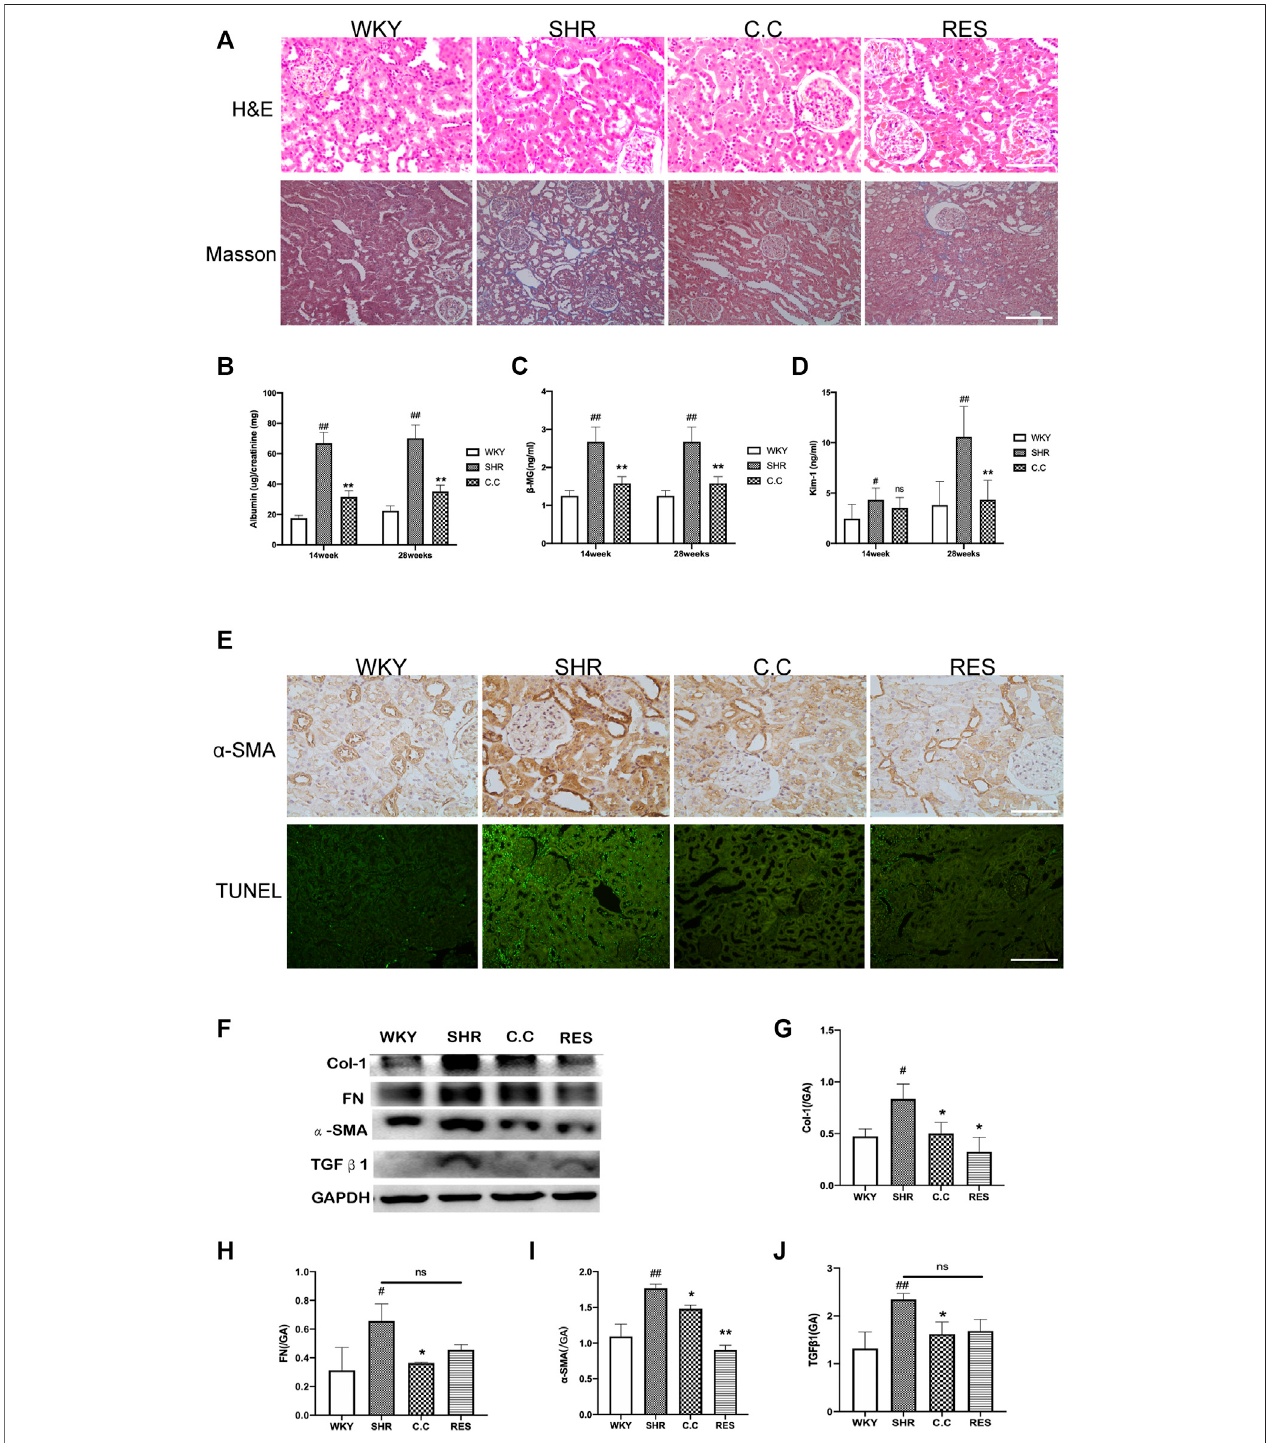
FIGURE 1 | C. cicadae alleviated SHR renal injury and fi brosis. (A) H&E staining (bar = 100 μ m) and Masson ’ s trichrome staining (bar = 40 μ m). (B) C. cicadae treatmentsigni fi cantlydecreasesACRlevelsafter 14and28 weeks. (C) C. cicadae treatment signi fi cantlydownregulates β 2-MGexpression after14and28 weeks. (D) C. cicadae treatment signi fi cantly reduced β 2-MG level at the 28th week. (E) The representative images and statistical graph of IHC staining for α -SMA (×200). Bar = 100 μ m. Apoptosis in rat renal tubules of various groups was evaluated by TUNEL assay. Scale bar: 40 μ m. (F) Effect of C. cicadae and RES on TGF β 1, α - SMA, FN, and Col-1 expression. (G – J) The relative intensities of fi brosis-related protein in kidneys were calculated after normalization against GAPDH. Data were presented as mean ± SD, n = 10 rats per group. For the WKY group vs the SHR group, # p < 0.05, ## p < 0.01. For the SHR group vs the C. cicadae group, * p < 0.05, ** p < 0.01. N.S. No signi fi